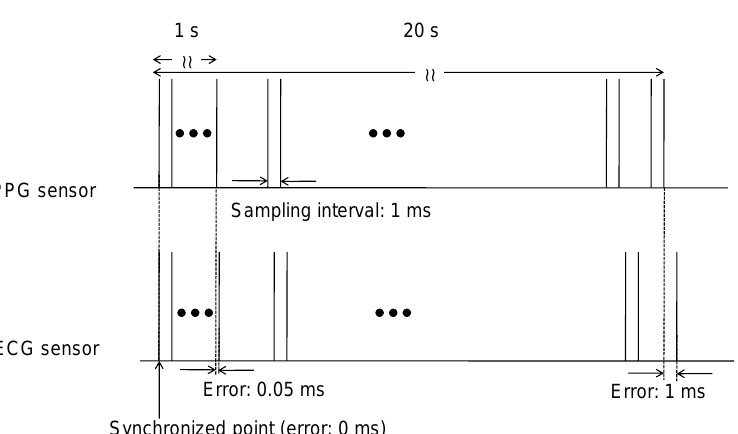
Figure 7. Accumulated synchronization